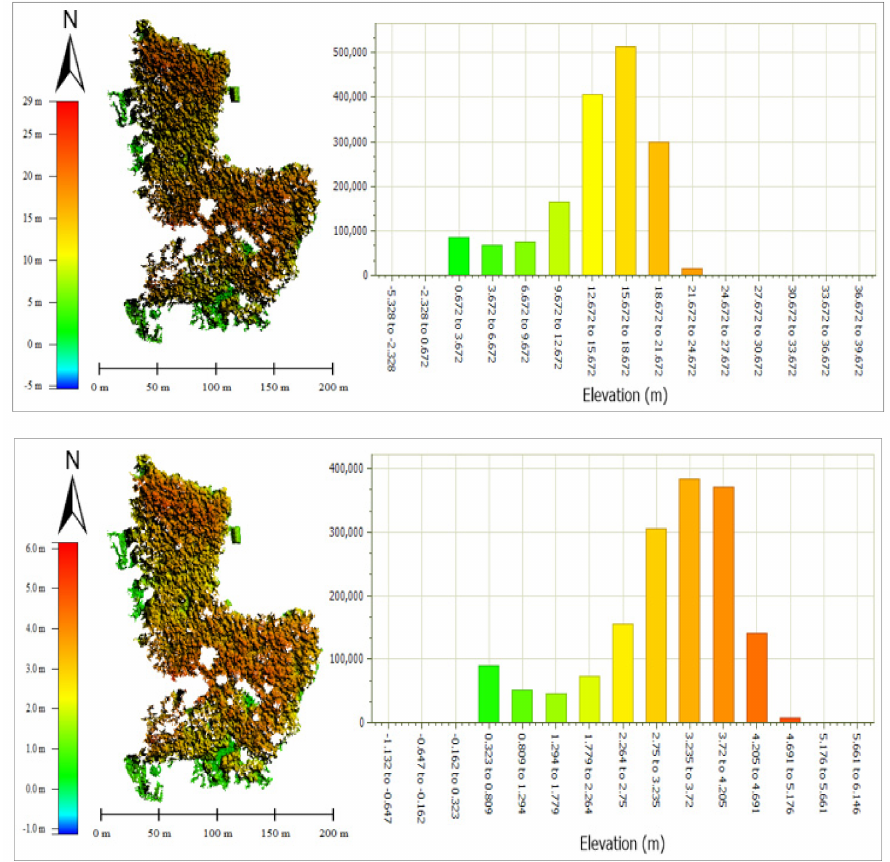
Figure 6. Comparison of the UAV-derived elevation model based on average elevation height distri- bution in histogram and elevation legend at ROI 2 during 2016 ( upper figure) and after ( lower figure). After the filtered DEM was generated, surface elevation between epochs was compared using the Global Mapper v22.0 software path profile tools. The path profile line was performed simultaneously on both epochs of filtered DEM. The comparison includes the deviation in height between two epochs of filtered DEM and the dominant height of each ROI. Based on Figure 7, ROI 2 showed an increment of DSM (unfiltered) and DEM (filtered) between 2016 and 2017, and a similar situation also happened at ROI 3, 5, 6, and 8. On the other hand, the contrast situations occurred at ROI 1, 4, and 7, where the decrement dominated the surface. The quality of the DEM using the SNERL filtering algorithm was evaluated and quantified based on the vertical accuracy assessment. The vertical accuracy assessment of DSM post-processed using the SNERL algorithm was compared to GNSS data, which resulted in an RMSE error of 0.089 m, a mean of 0.039 m, and a standard deviation (SD) of 0.322 m. So, it can be concluded that the SNERL filtering algorithm accuracy was less than 1